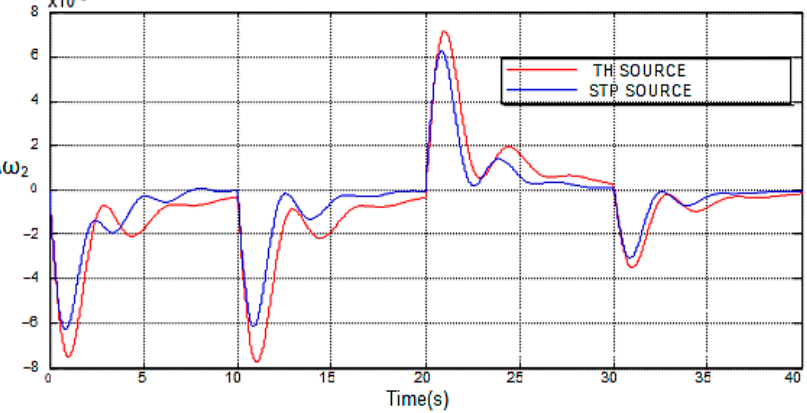
Figure 15. Frequency variations of area 2 without and with STP and variable SLP.